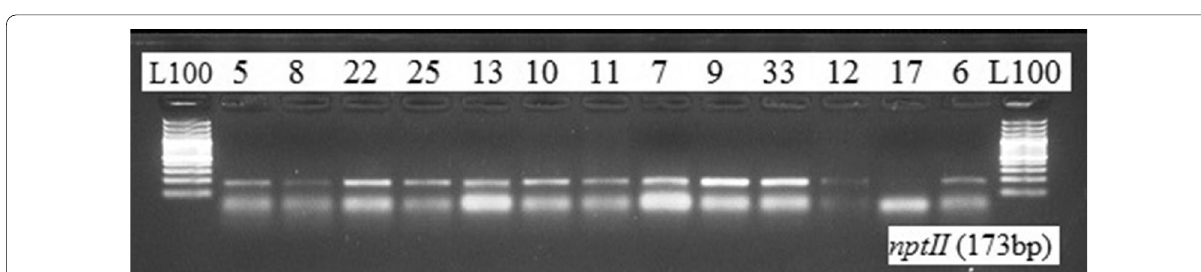
Fig. 3 Selected PCR amplification products of nptII (173 bp) in some of the collected plant samples. Sample 33 is for one of the tested animal